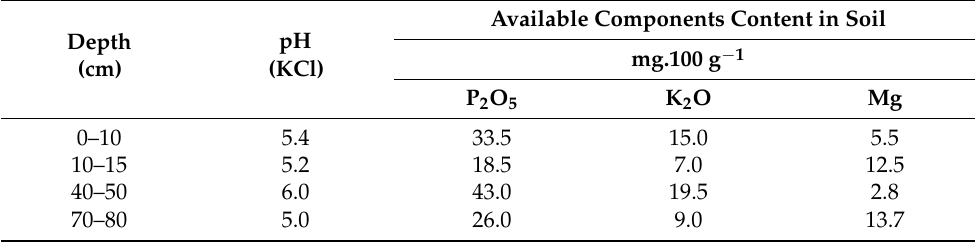
Table 3. Chemical characteristics of soils after finishing experiment with reseeding of T.